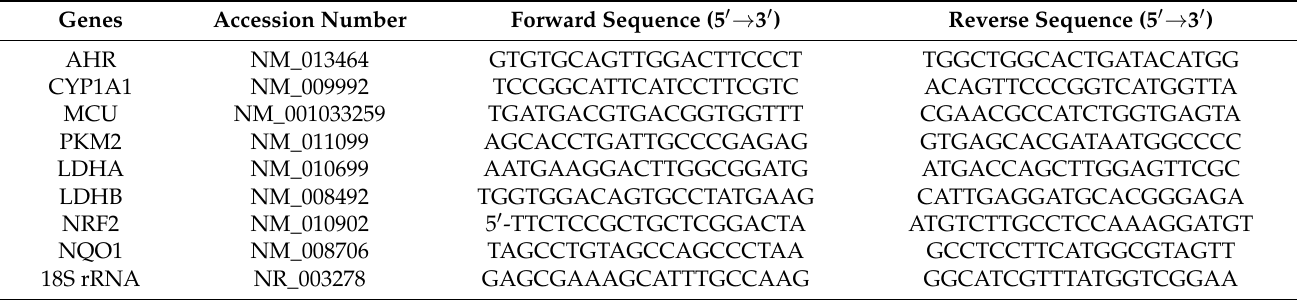
Table 1. Sequences of primers used for the real-time